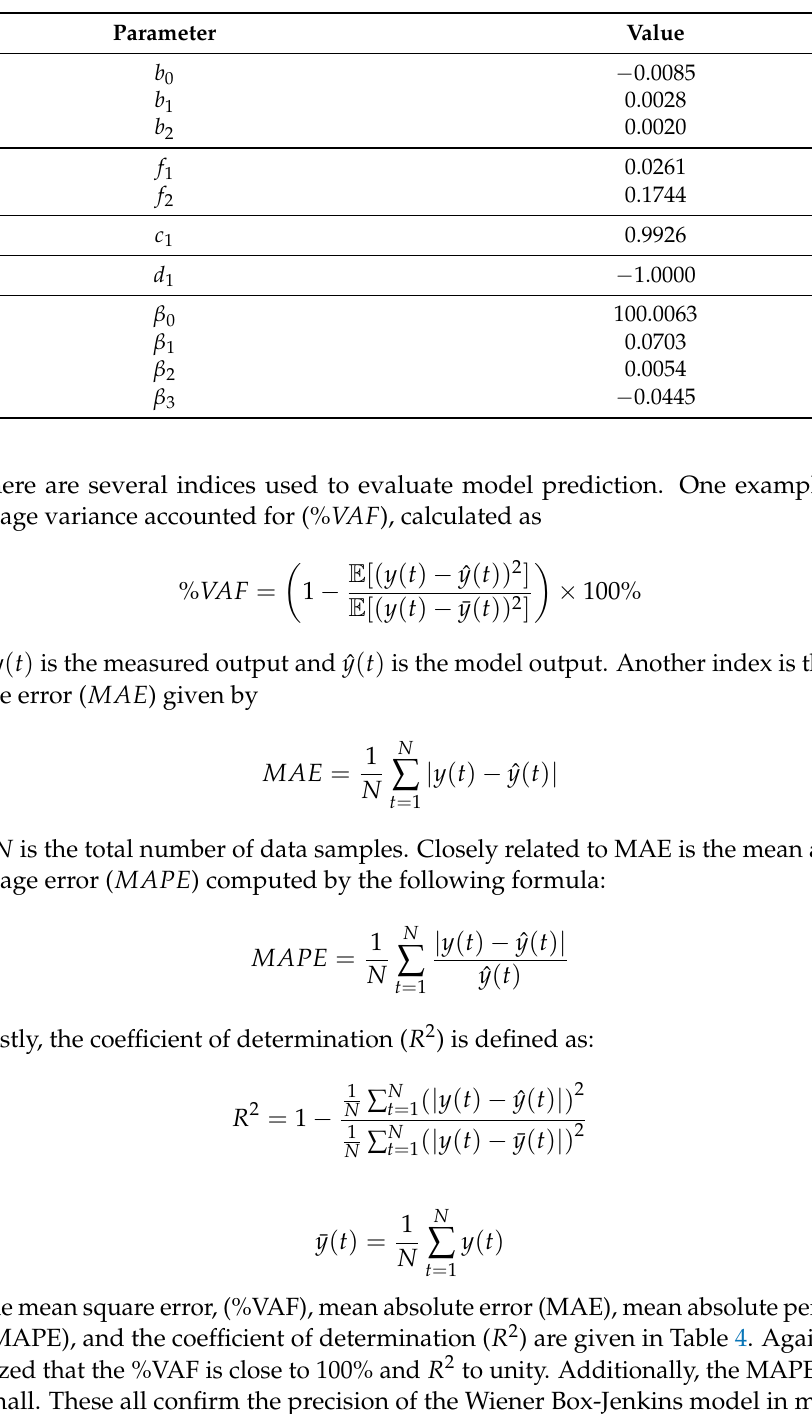
Table 3. Average estimates of the Wiener Box-Jenkins model parameters using PSO.